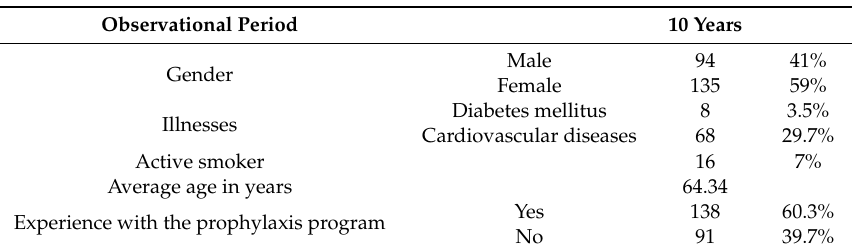
Table 1. Pertinent patient data.